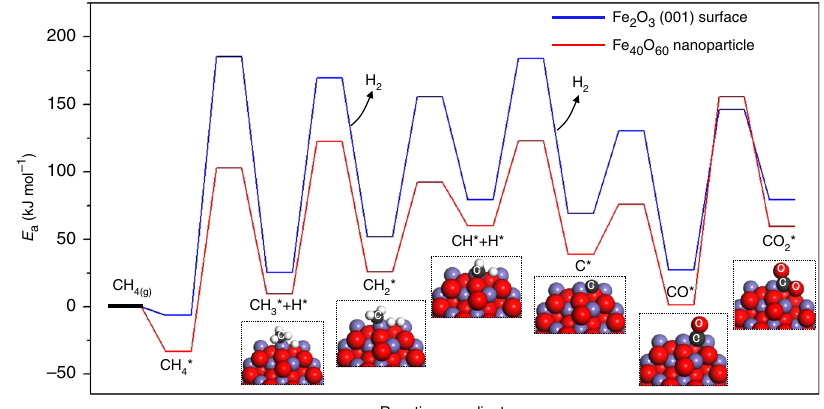
Fig. 5 Energy pro fi le of CH 4 partial oxidation on Fe 40 O 60 nanoparticle and Fe 2 O 3 (001)